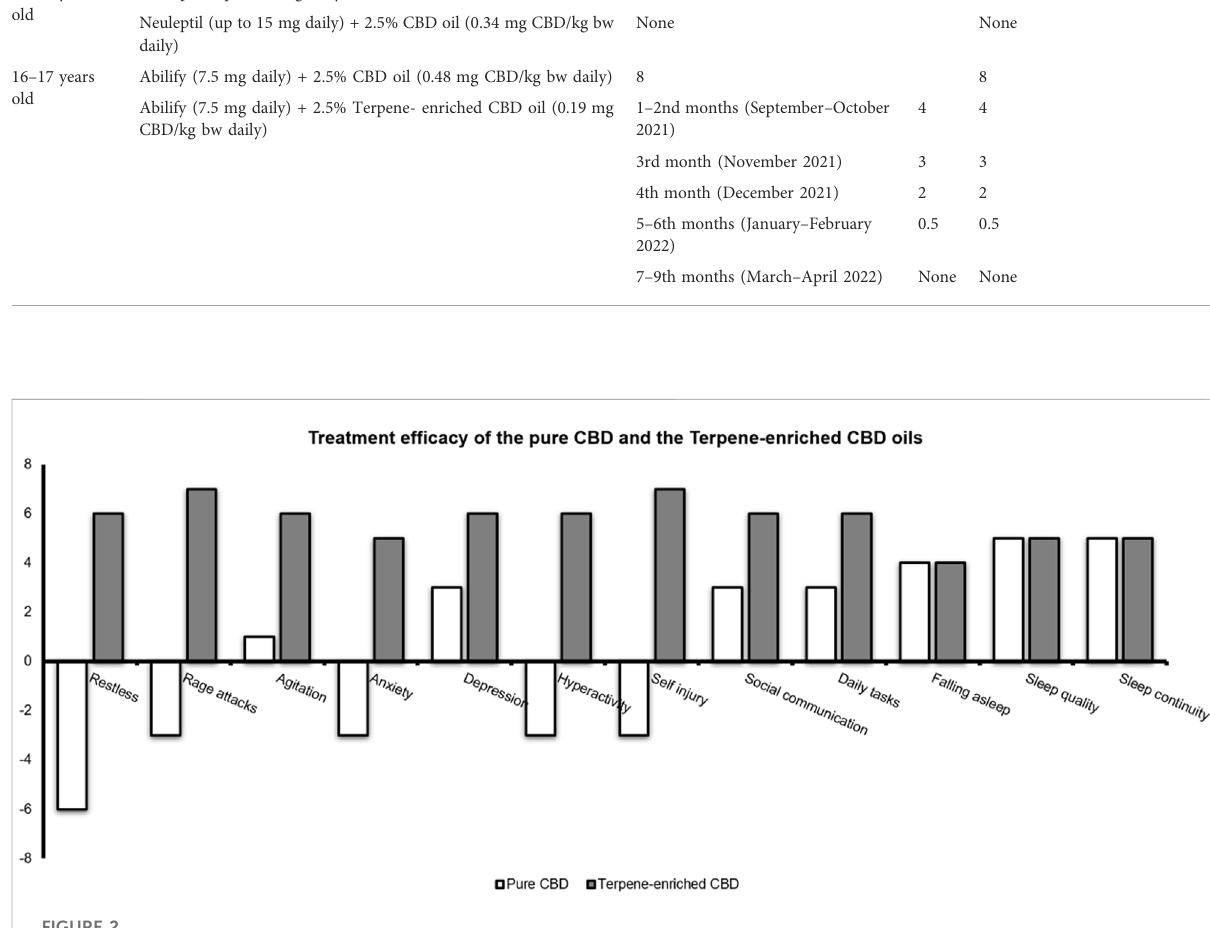
FIGURE 2 Treatment ef fi cacy of the pure CBD (white bars) and the Terpene-enriched CBD (gray bars) oils. G ’ s parents were asked to rate symptoms ’ severity in their child following CBD oil treatment ( “ How would you evaluate your child ’ s symptom severity following oil treatment (how did the oil affected your child in regard the following symptoms)? “ . A self-reported questionnaire, see Supplementary data). This was evaluated separately for the pure CBD and the terpene-enriched CBD